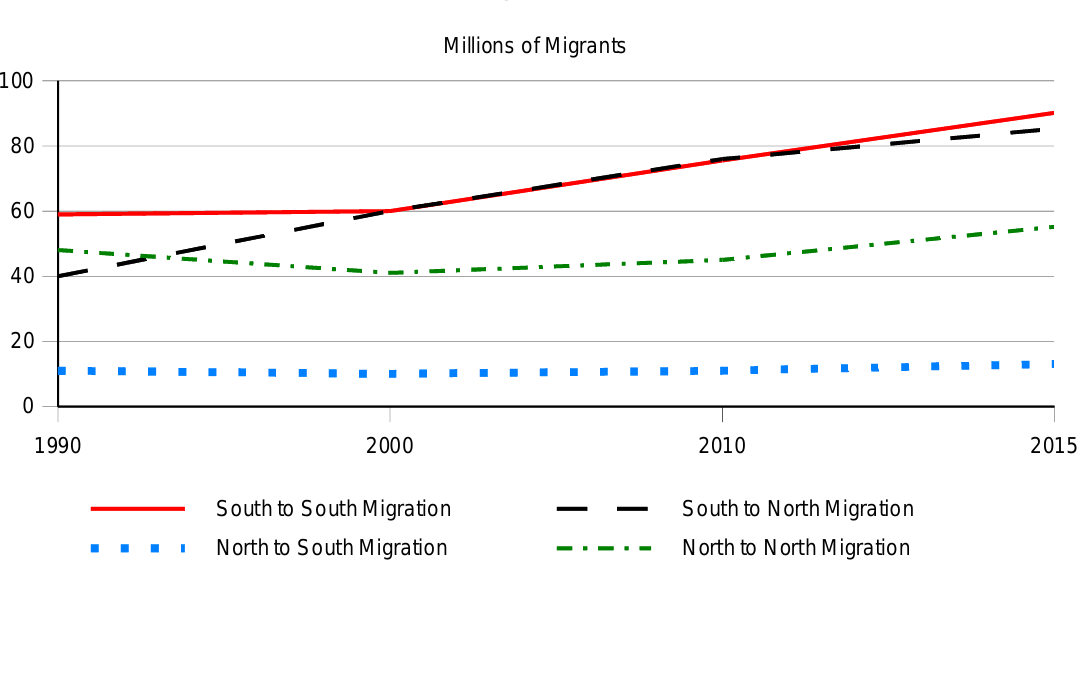
Figure 4. Transnational Migration Flows in the 21 st Century World-System Part A. Transnational Migration Flows, 1990 to 2015